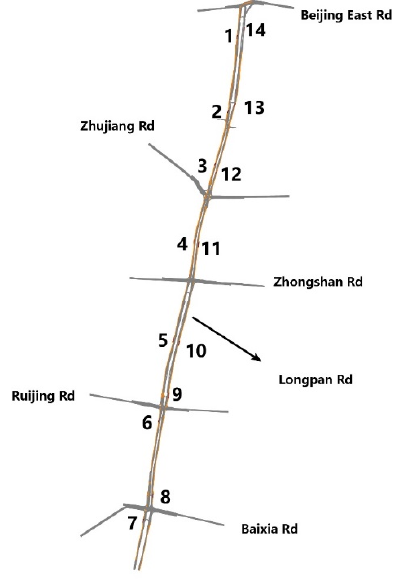
Figure 3. Location of the 14 stops along Longpan Road.